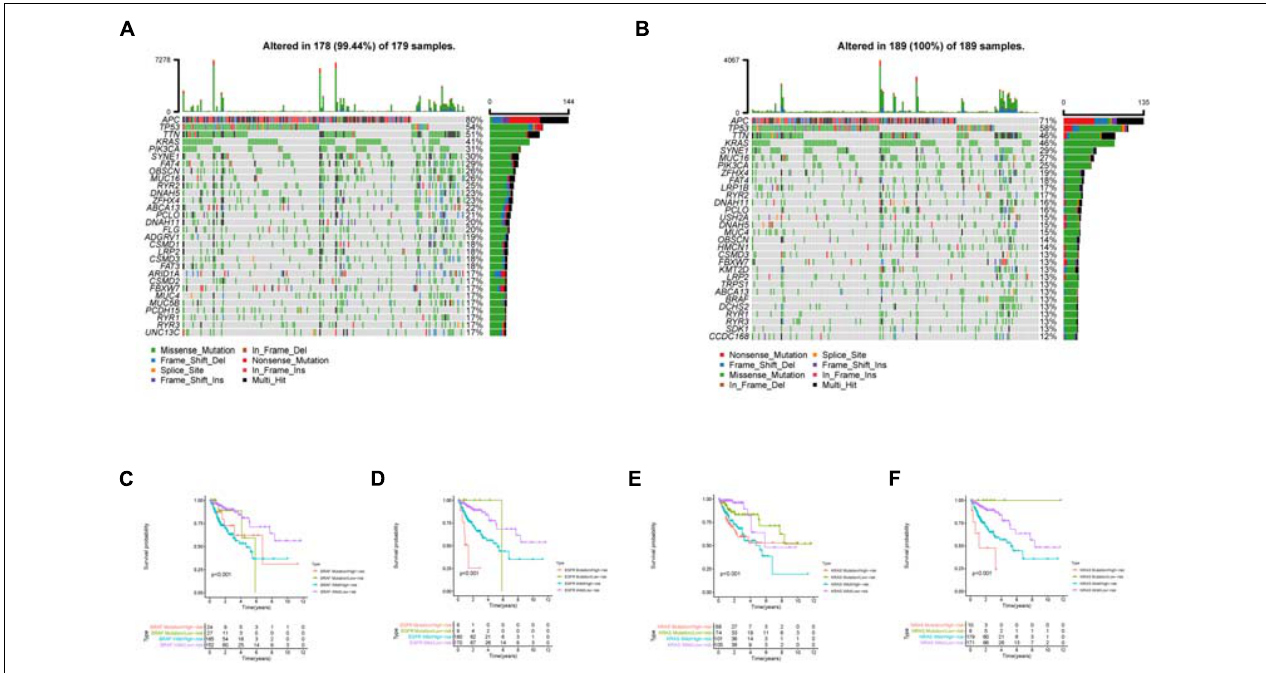
FIGURE 10 | Mutation analysis of the high and low risk groups. (A) is the mutation waterfall plot of the low risk group. (B) Is the mutation waterfall plot of the high risk group. The ordinate is the gene name and the abscissa is the sample name. Different color represents different mutation type. (C–F) Effect of common target gene mutation on patients’ survival in the high and low risk